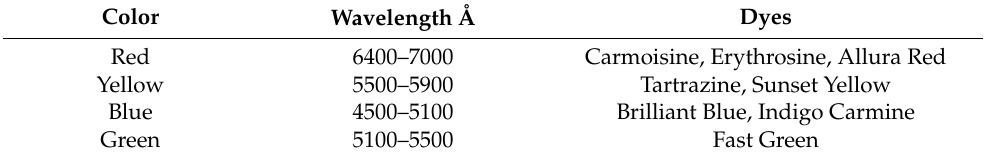
Table 1. List of food permitted dyes along with wavelength and color they impart. Color Wavelength Å Dyes Red 6400–7000 Carmoisine, Erythrosine, Allura Red Yellow 5500–5900 Tartrazine, Sunset Yellow Blue 4500–5100 Brilliant Blue, Indigo Carmine Green 5100–5500 Fast